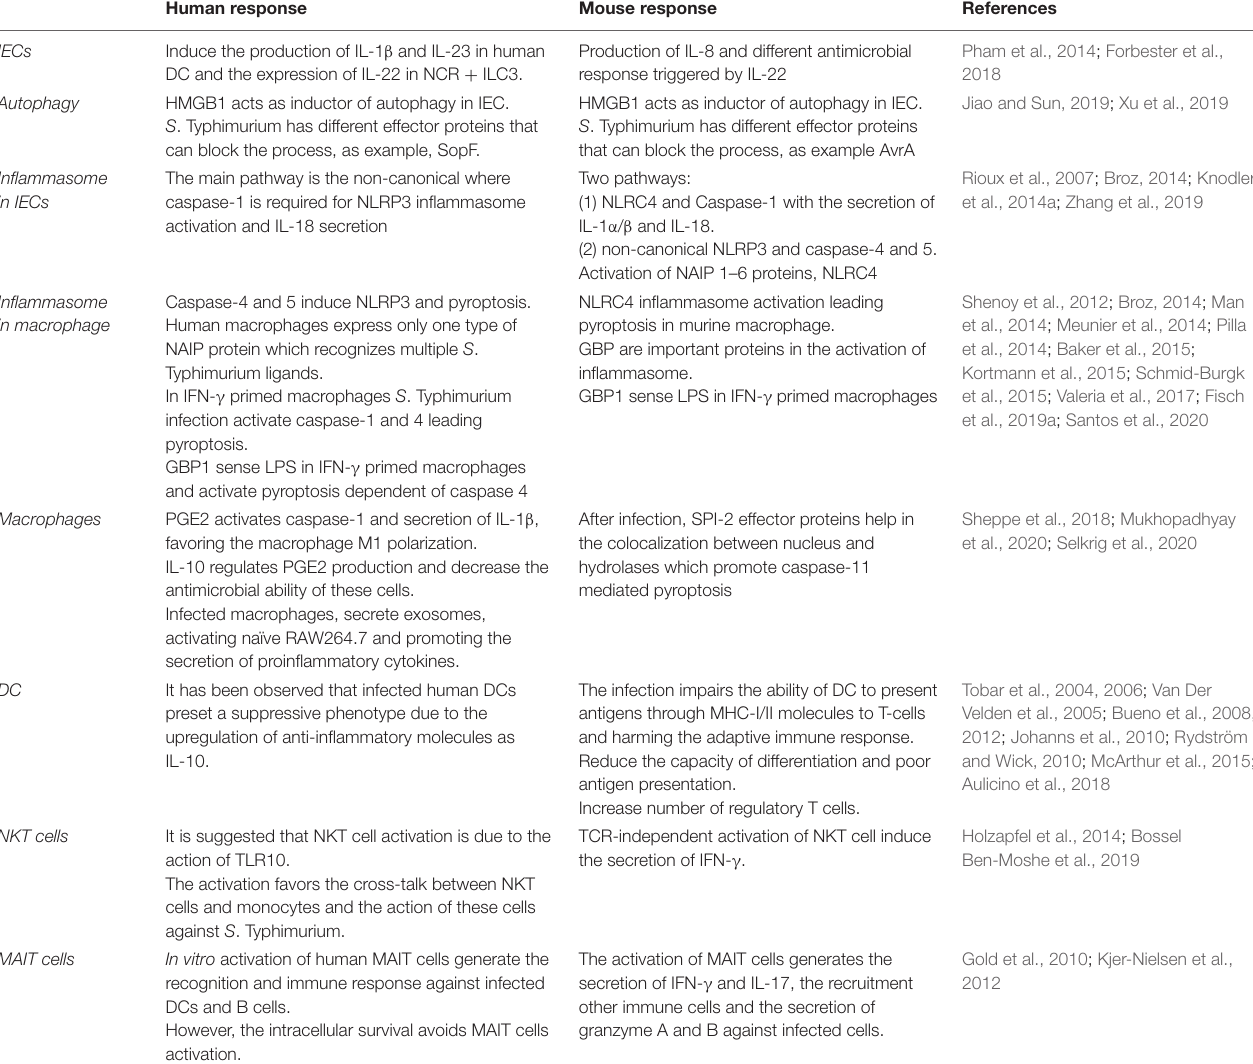
TABLE 2 | Differences between immune response in human and mice derived cells infected with S.